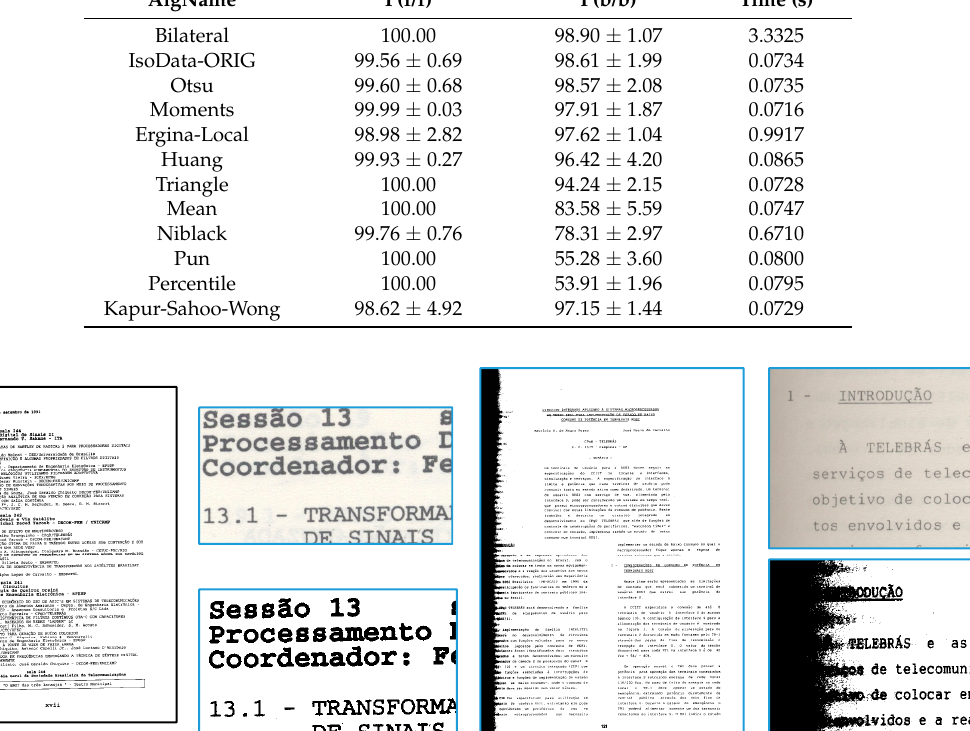
Figure 6. Images from LiveMemory with the best (( left )—P(f/f) = 100.00, P(b/b) = 99.99) and the worst (( right )—P(f/f) = 100.00, P(b/b) = 95.97) binarization results for the bilateral filter with zooms from the original ( top ) and binary ( bottom ) parts.